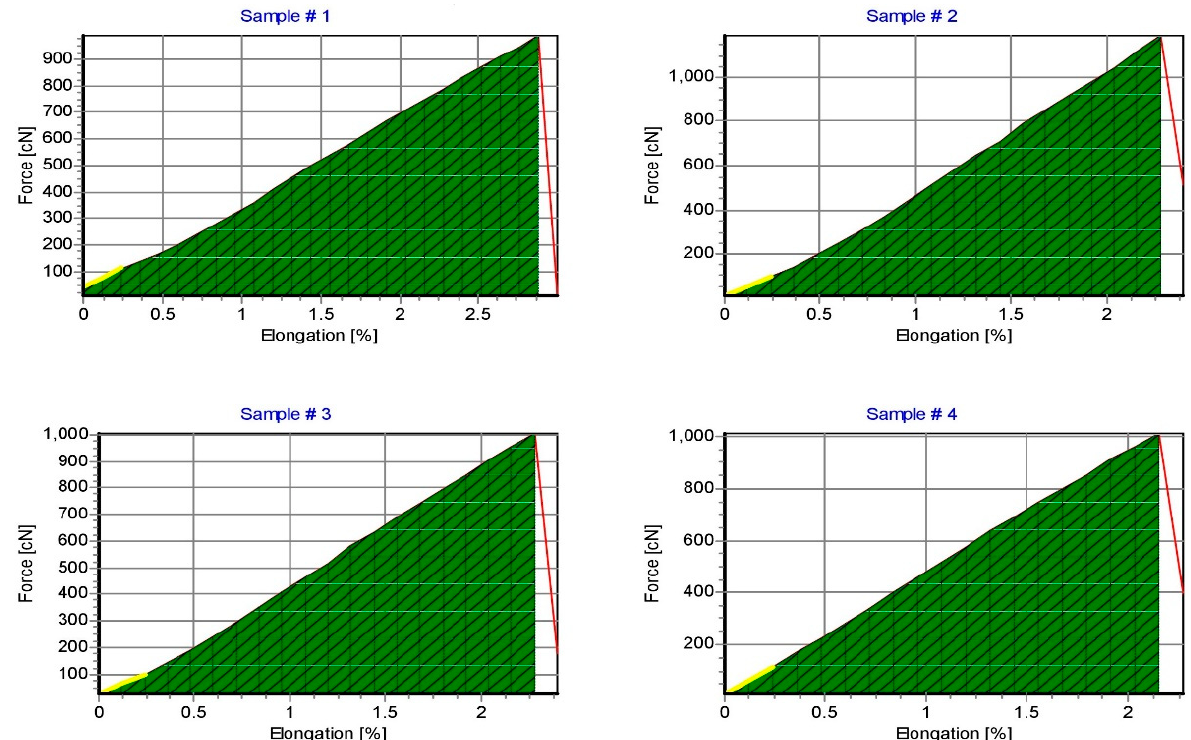
Figure 8. The work of rupture covered by force versus elongation.